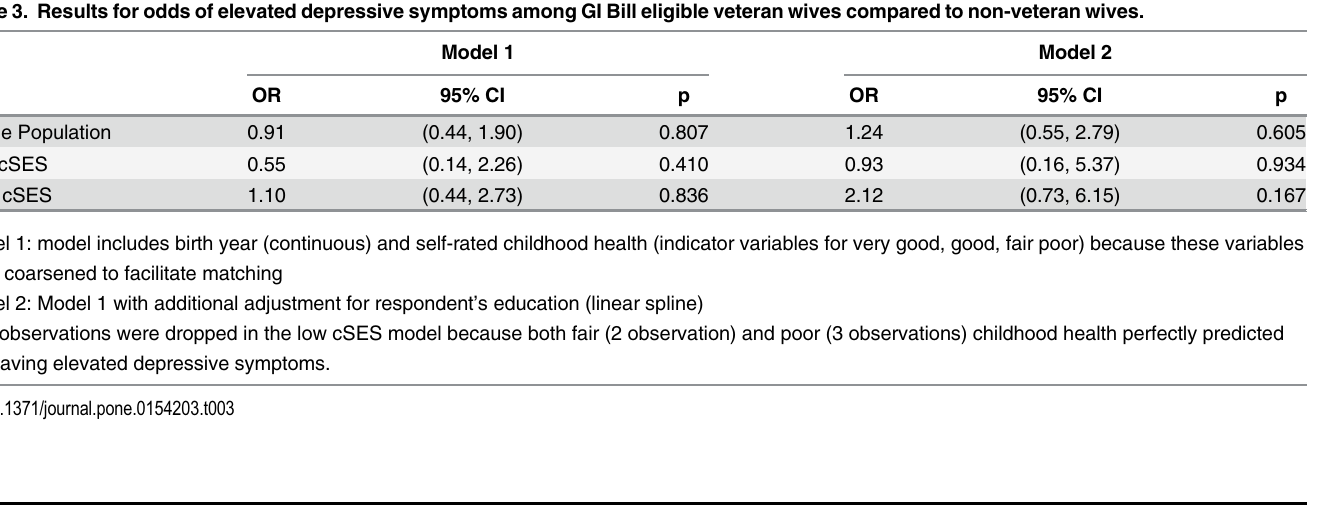
Table 3. Results for odds of elevated depressive symptoms among GI Bill eligible veteran wives compared to non-veteran wives.